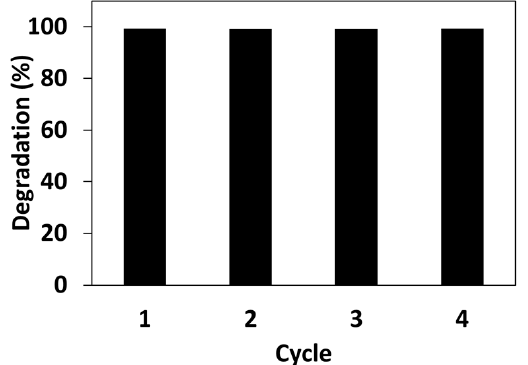
Figure 12. Degradation efficiency of the reused catalyst. Reaction conditions: [catechol-HCP-Fe] = 1 g/L, [H 2 O 2 ] = 0.5 M, [MB] = 100 ppm, pH = 6 (neutral pH), room temperature (27 ◦